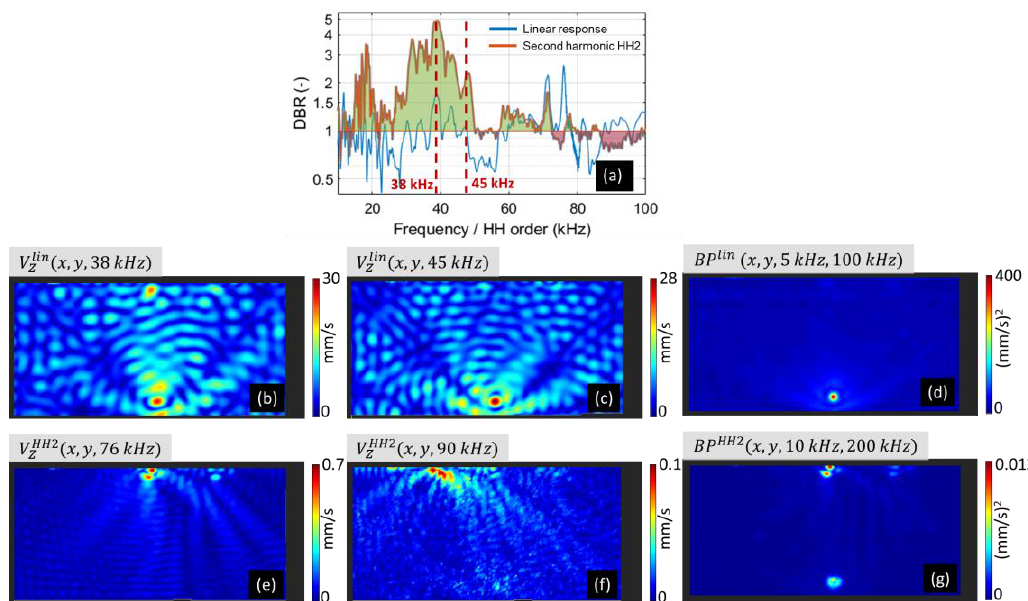
Figure 7. Side-delamination response analysis: ( a ) defect-to-background ratio of linear and second harmonic component, ( b - d ) linear response amplitude at 38 kHz, at 45 kHz and band power map, ( e - g ) second harmonic response amplitude at 2 × 38 kHz, at 2 × 45 kHz and band power map.